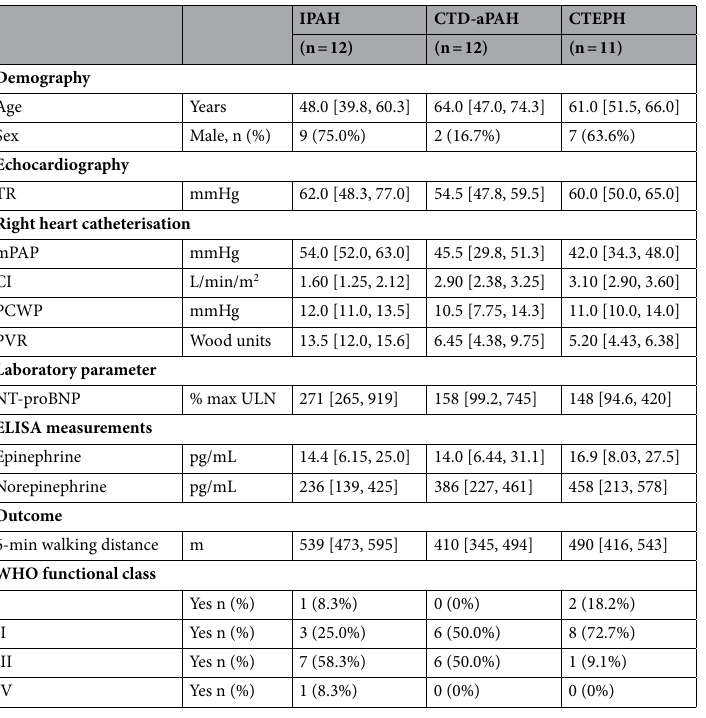
Table 1. Patient demographics, admission vitals, disease severity, and catecholamine measurements in 35 PH patients. Medians (IQR) or n (%) are reported. CI, cardiac index; mPAP, mean pulmonary arterial pressure; NT-proBNP, N-terminal ( NT )-pro brain natriuretic peptide (BNP); PCWP, pulmonary capillary wedge pressure; PVR, pulmonary vascular resistance; TR, tricuspid regurgitation; ULN: upper limit of